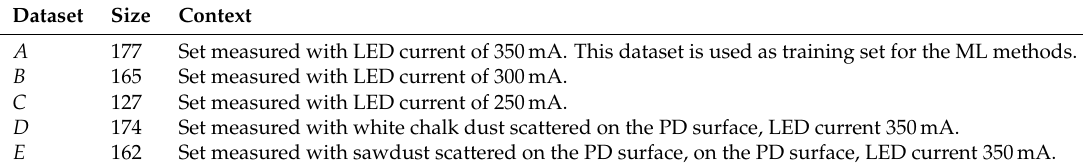
Figure 9. Dust particles scattered on the aperture on the receiver, representing possible changes in the environment during operation of the VLP system where robustness is required. Table 3. Summary of the acquired datasets with their reference name and the context describing the experiment